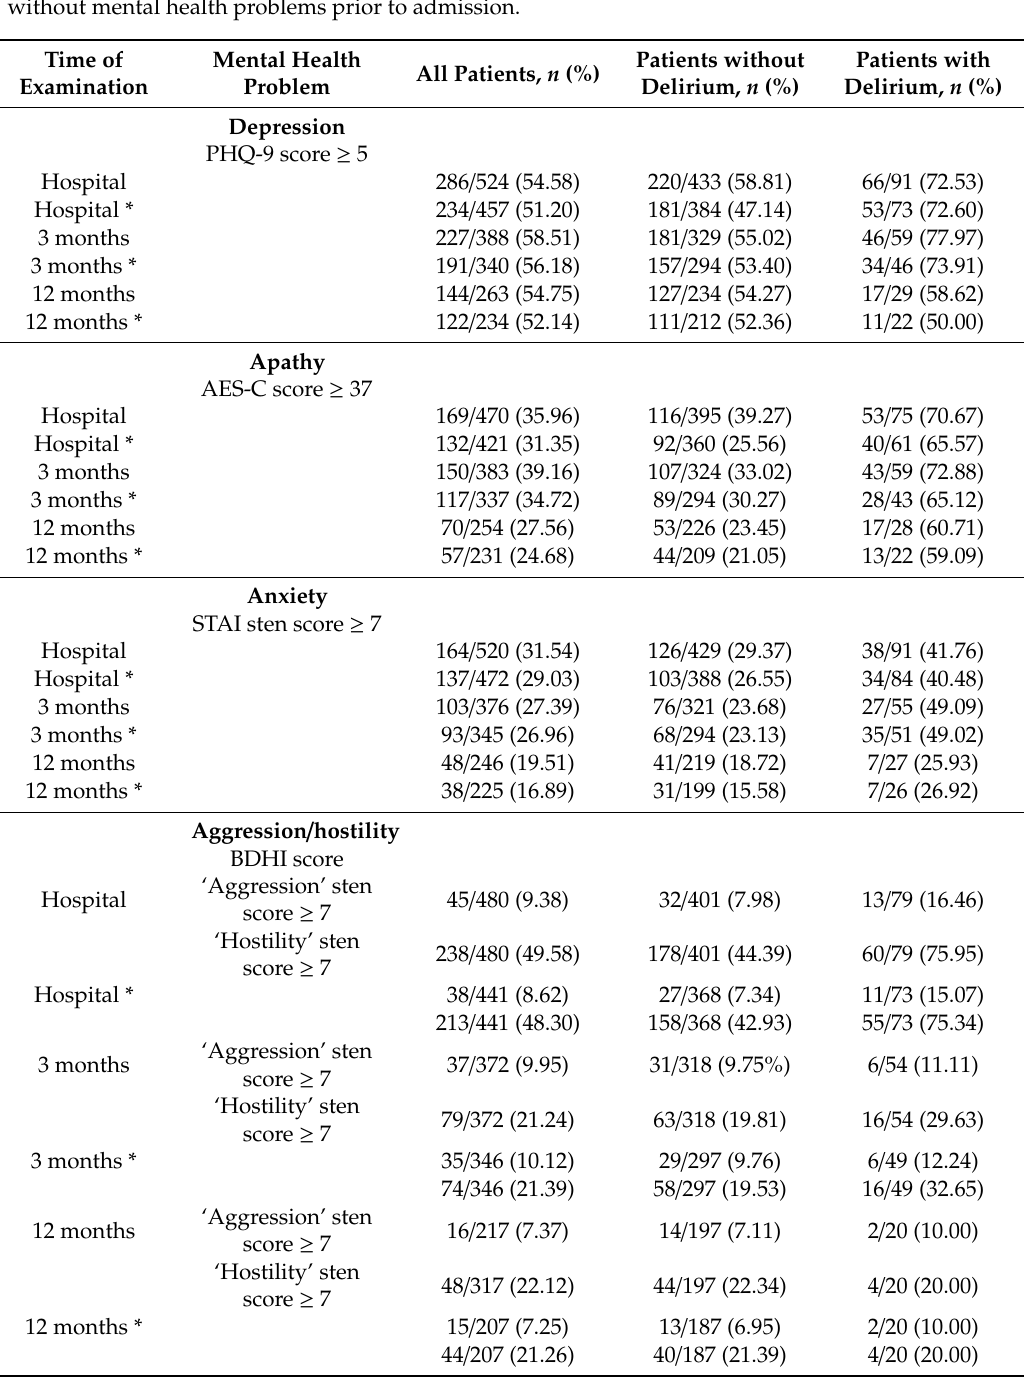
Table 1. The prevalence of depression, apathy, fear and aggression / hostility among patients with and without mental health problems prior to